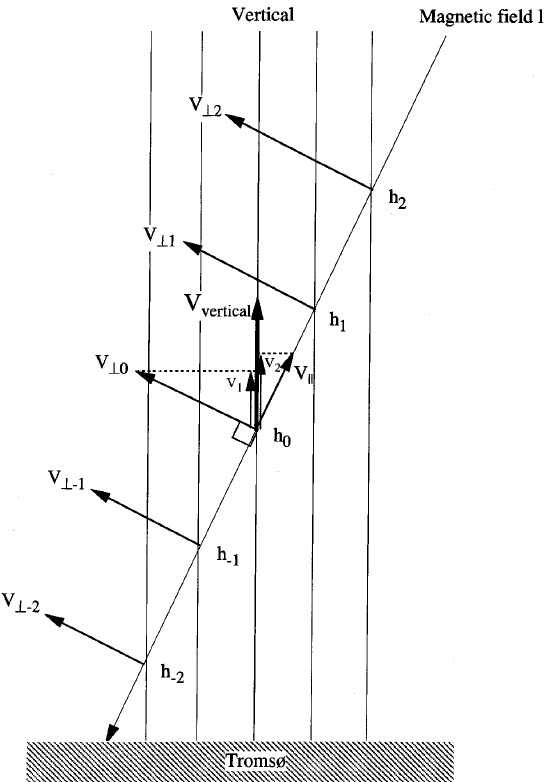
Fig. 6. The K dependence of the ion upflow and downflow for all P MLTs